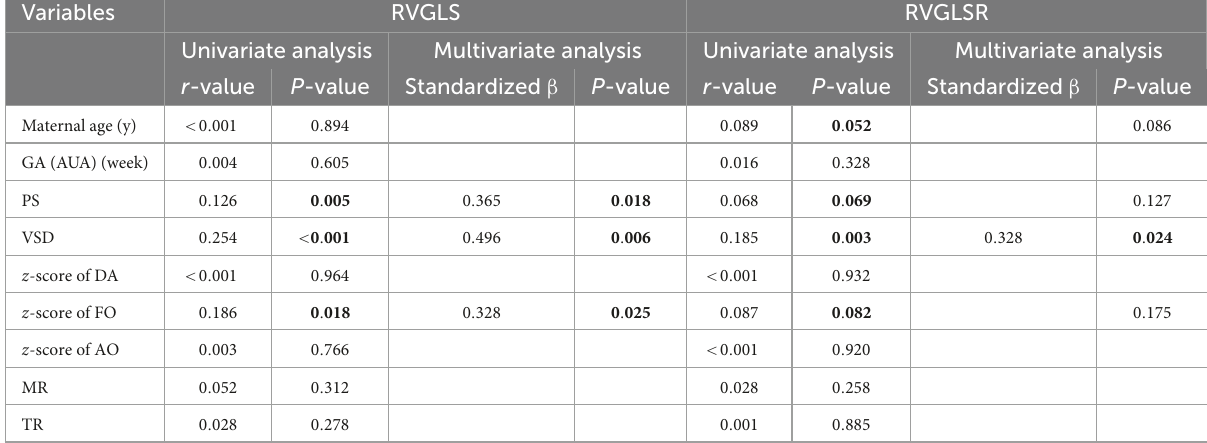
TABLE 5 Univariate and multivariate regression analyses for RVGLS and RVGLSR in the fetuses with d-TGA. Variables